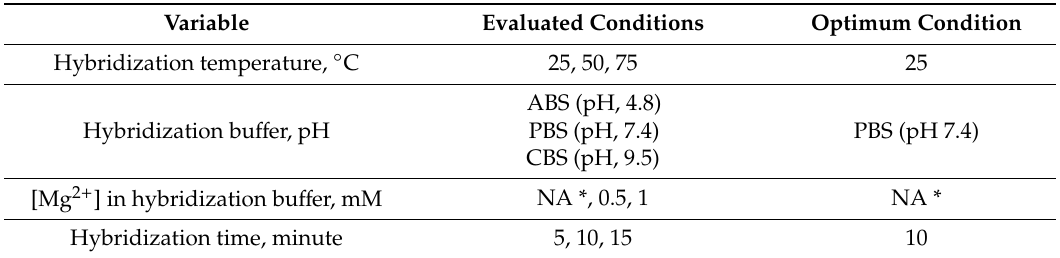
Table 1. Experimental variables optimized for the impedimetric sensing performance of the array biosensor. Variable